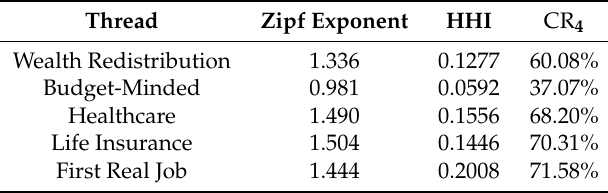
Table 2. Concentration measures. HHI—Hirschman–Herfindahl